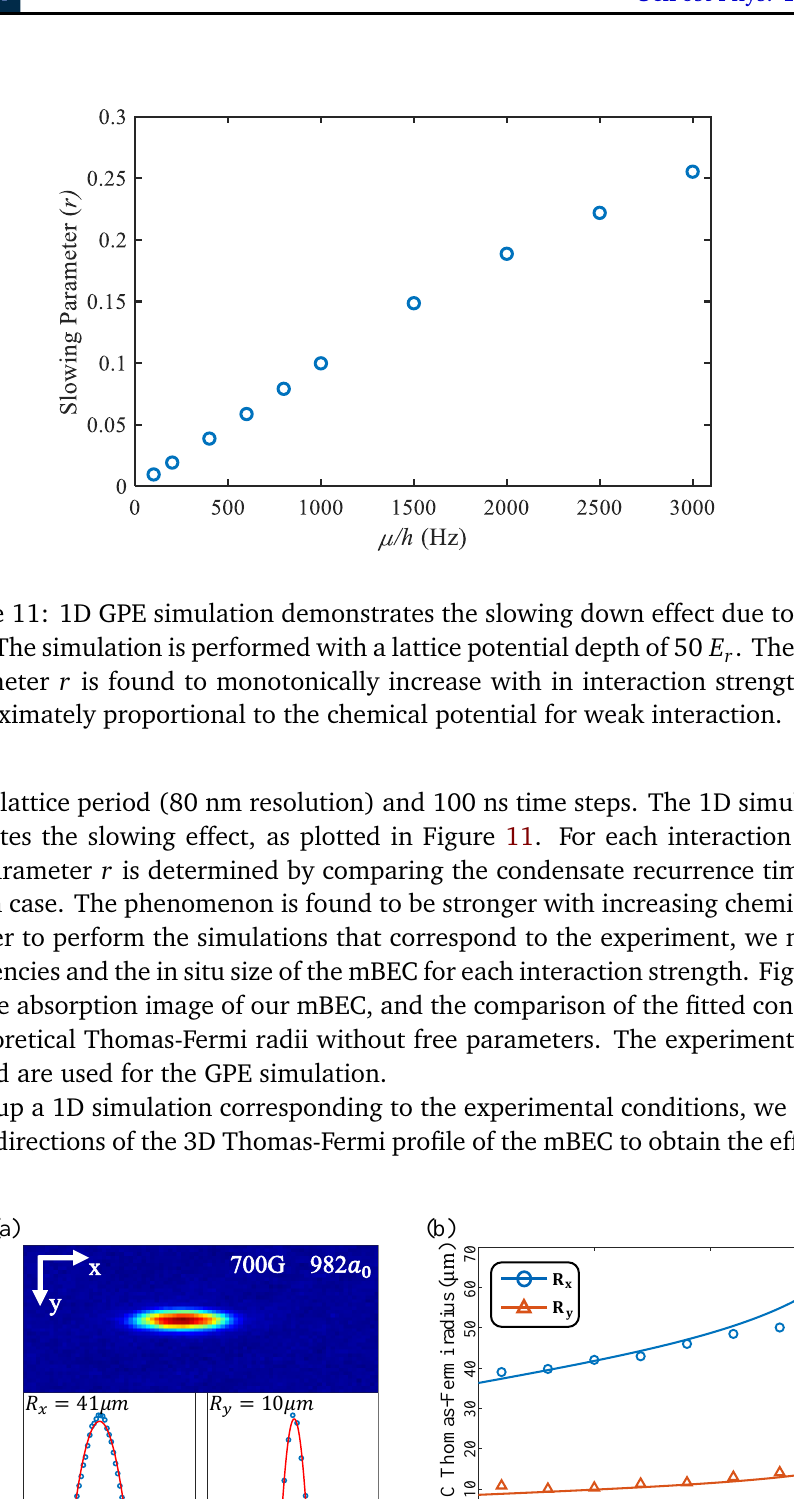
Figure 12: (a) In situ profiles of the mBECs at 700G and (b) the measurement of Thomas-Fermi radius (open symbols) with calculated result (solid line). Trap fre- ) = ( 16,74,68 ) Hz and molecule number 3000 are used for the quencies ( f , f , f x y z calculation. The results agree well with theoretical prediction based on the mea- sured molecule number and trap